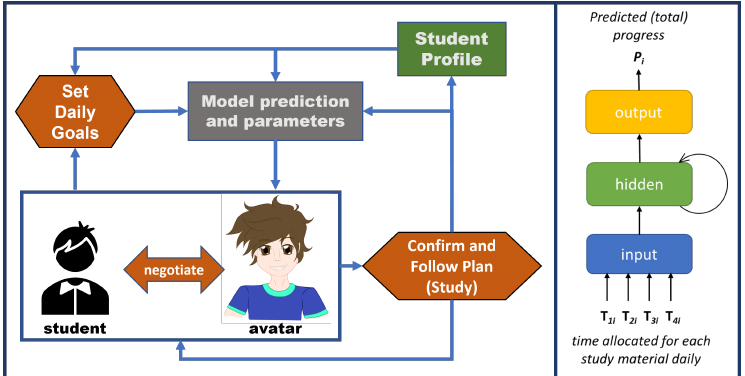
Figure 2. System Architecture ( Left ). The avatar follows a negotiation-based approach to interact with the student during the goal-setting process. The avatar visualizes the underlying RNN model parameters (e.g., input/output pairs, input uncertainty, model accuracy) through text and facial expressions to provide insights about the efficiency and the expected learning outcomes of the plan. The RNN architecture ( Right ). Each network layer represents the daily goals and can predict the estimated learning outcomes (e.g., predicted daily progress/task completion) based on the previous daily goals. The predicted weekly learning outcome is the final layer